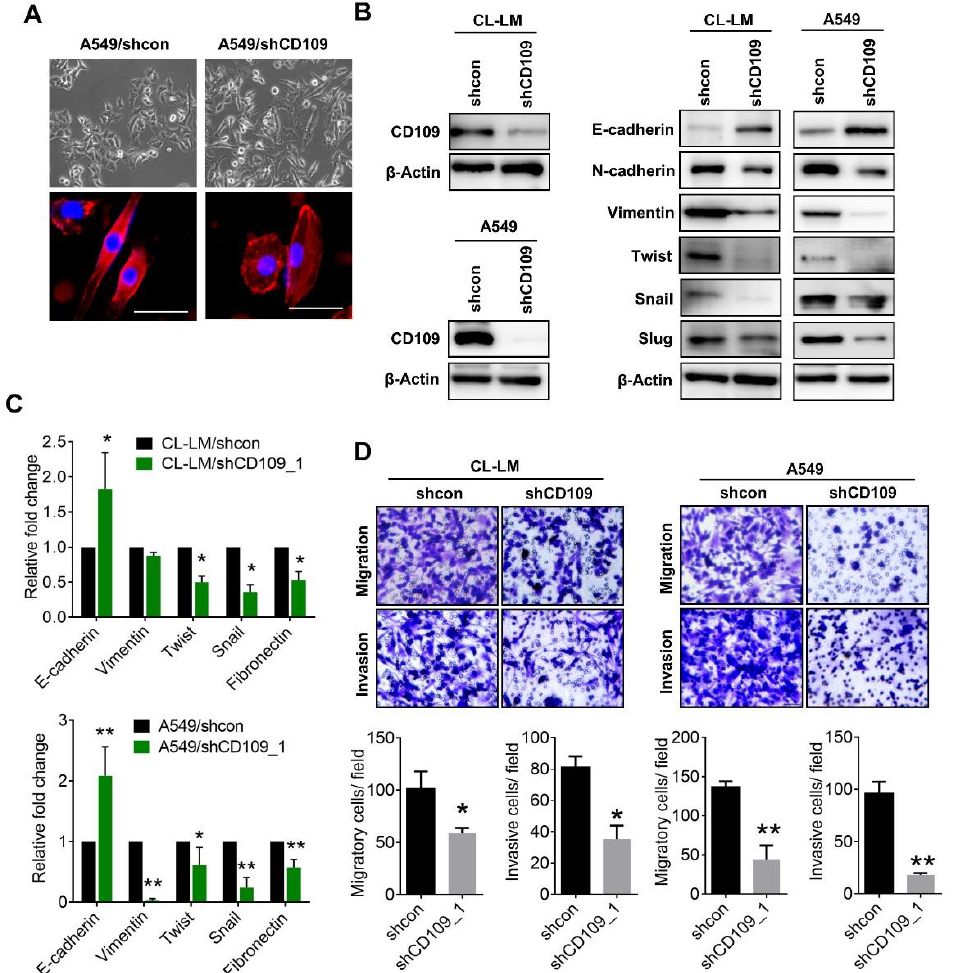
Figure 2. Suppression of CD109 downregulates epithelial-to-mesenchymal transition (EMT) gene expressions and mobility in lung adenocarcinoma cells. ( A ) Bright field images of cell morphology in A549/sh-control and A549/shCD109 cells (upper panel). Fluorescent images of actin filaments in A549/sh-control and A549/shCD109 cells (lower panel). Scale bar = 50 μm. ( B ) Western blot analyses of CD109 (left panel) and EMT-related protein levels (right panel) in CD109-knockdown A549 and CL-LM cells. ( C ) CD109-knockdown suppressed EMT-related gene expressions, as determined by real-time PCR assay. ( D ) Transwell analyses of migratory and invasive capacities of CD109-knockdown A549 and CL-LM cells. Data were derived from three random fields by three independent experiments, and results are expressed as the mean ± SD. * p < 0.05; ** p < 0.01, as determined by an unpaired t -test.